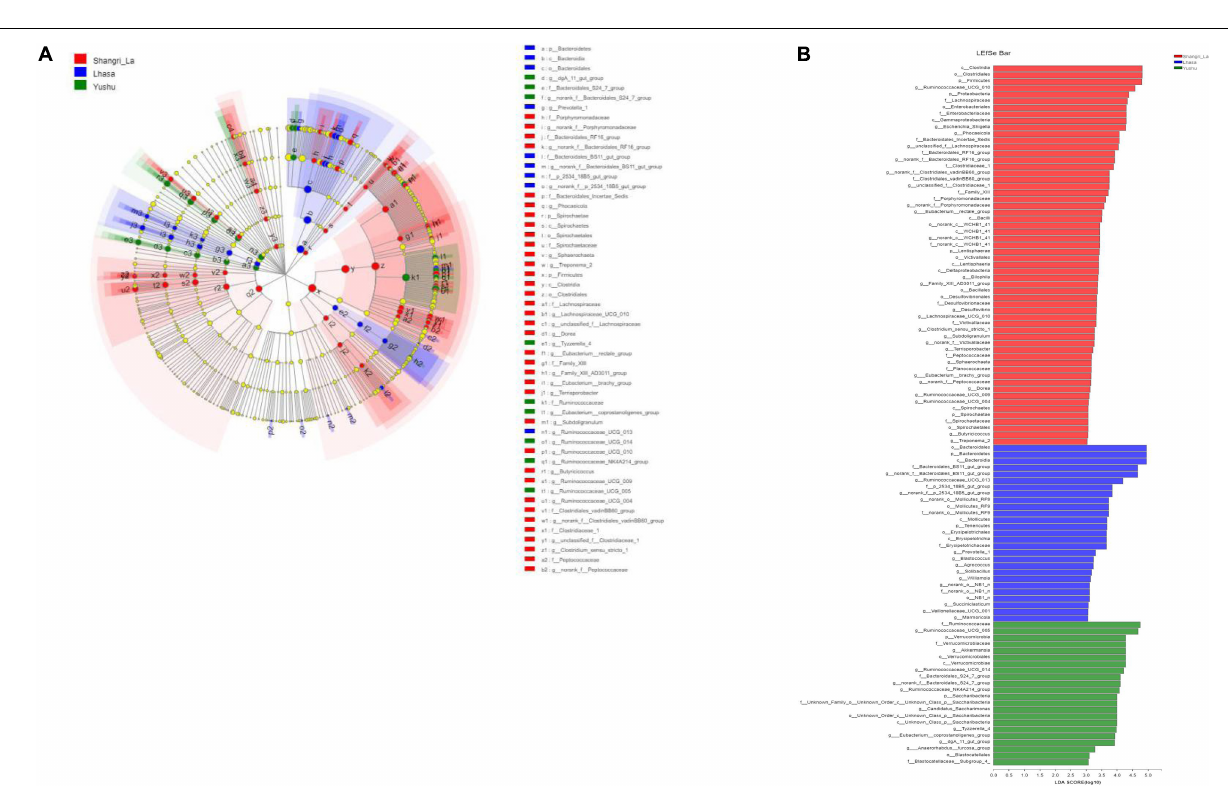
FIGURE 6 | LEfSe analysis of gut microbiota. (A) Linear discriminant analysis (LDA) effect size (LEfSe) conducted on the intestinal microbiota of yaks from different regions ( p < 0.05, LDA > 3). Different colors and sizes of nodes indicate microbial groups with significant differences and enriched species abundance. Light yellow nodes indicate groups with no significant difference. (B) LEfSe for three